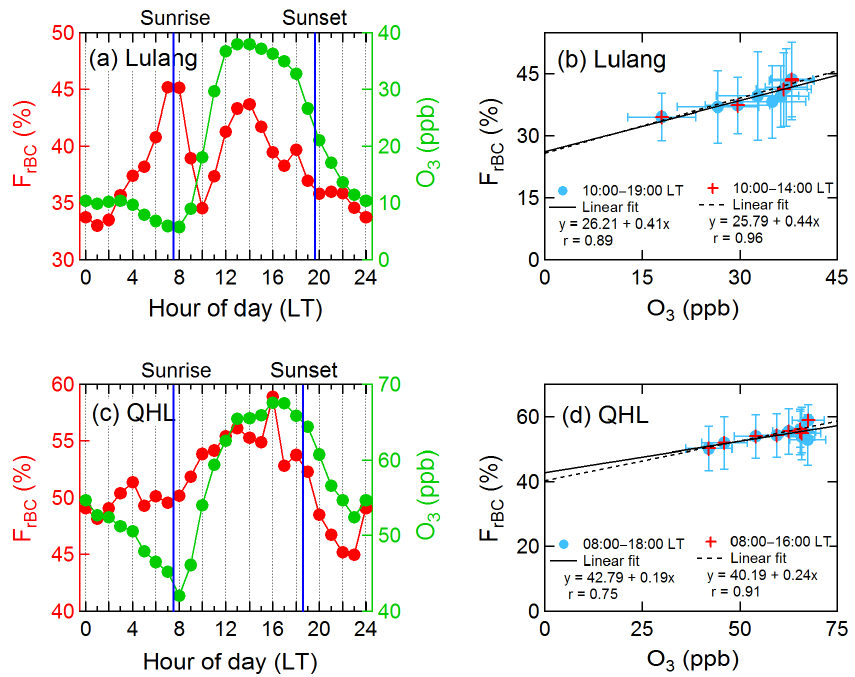
Figure 8. (a, c) Diurnal variations of the hourly averaged number fraction of thickly coated refractory black carbon particles ( F rBC ) and O 3 mixing ratios at Lulang and Qinghai Lake (QHL) and (b, d) linear regressions between F rBC and O 3 at these two